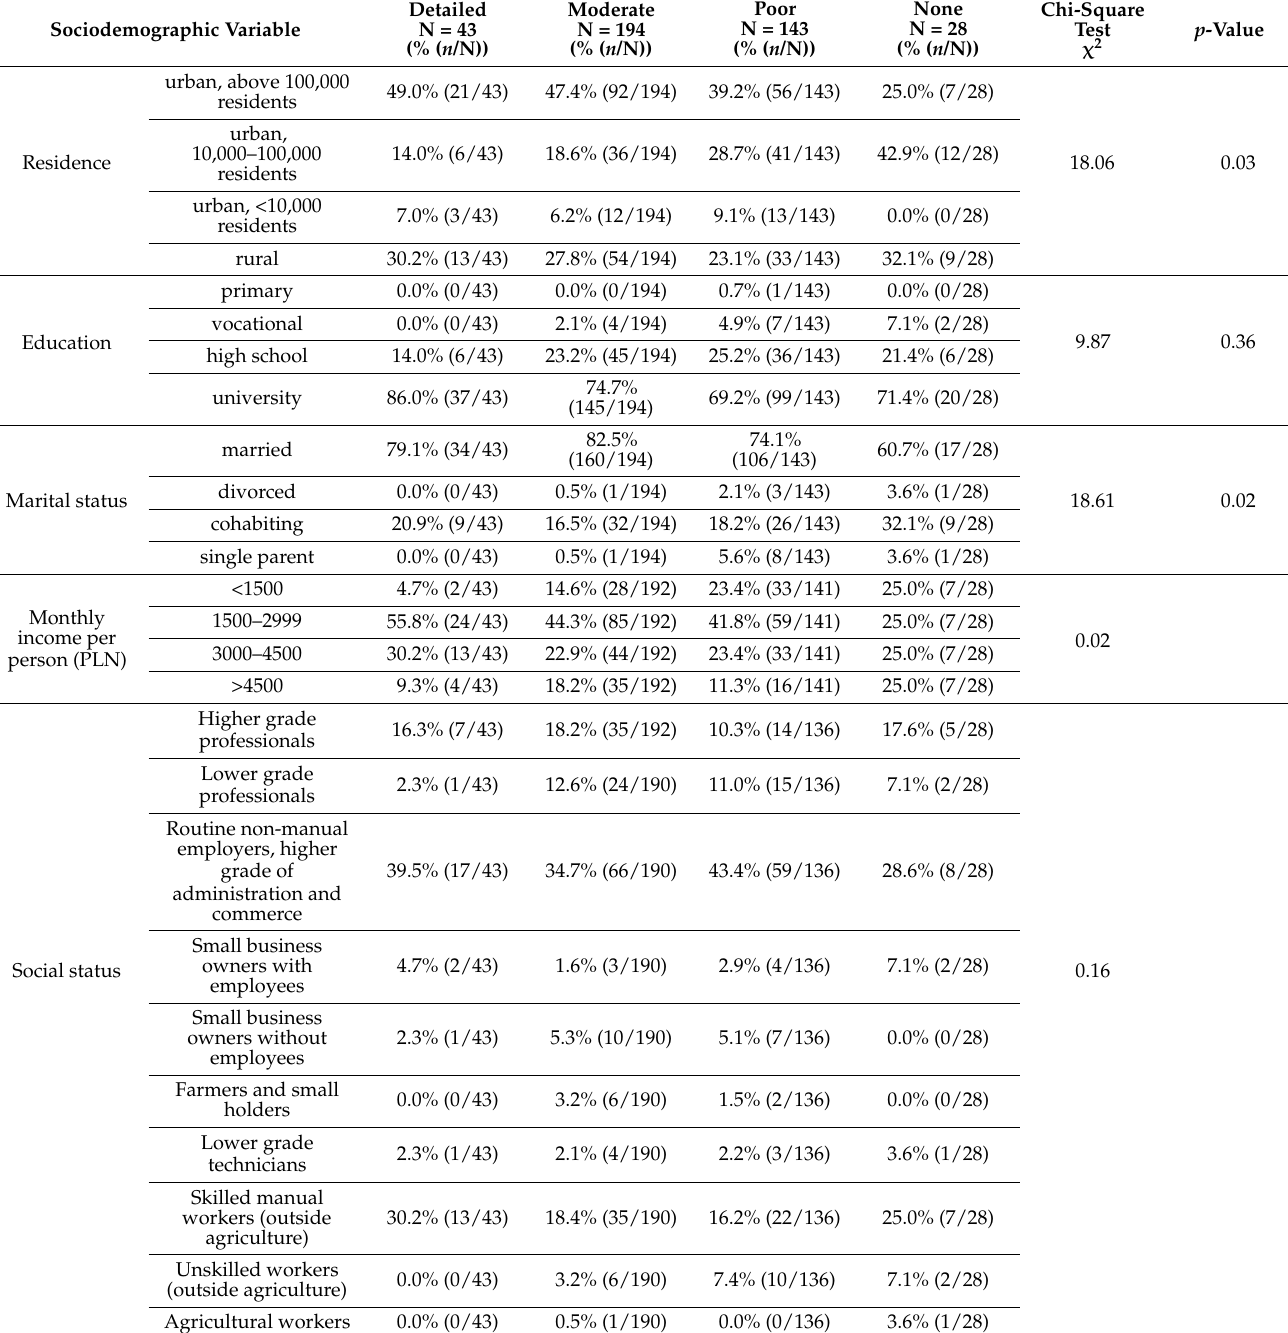
Table 3. GDM knowledge level in relation to sociodemographic